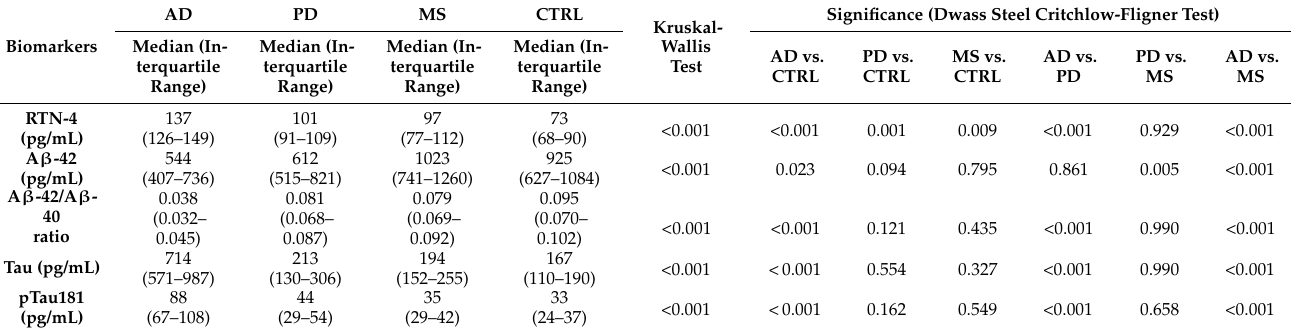
Table 1. CSF biomarkers levels in the investigated